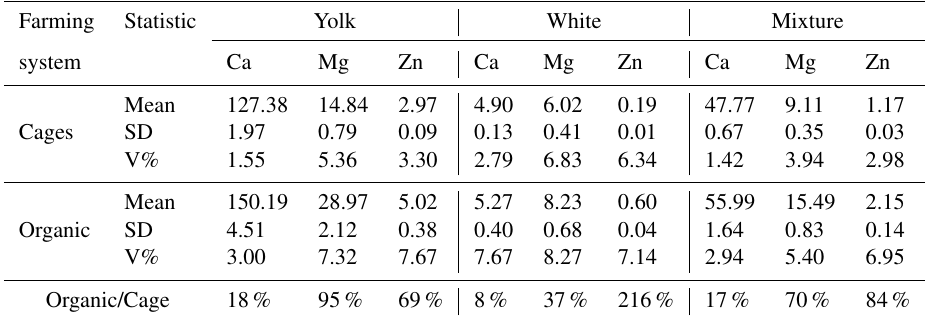
Table 4. Content of Ca, Mg and Zn in the yolk, white, and mixture of yolk and white depending on the farming system, and difference (in %) in the content of Ca, Mg and Zn in organic and battery-cage eggs. Farming Statistic